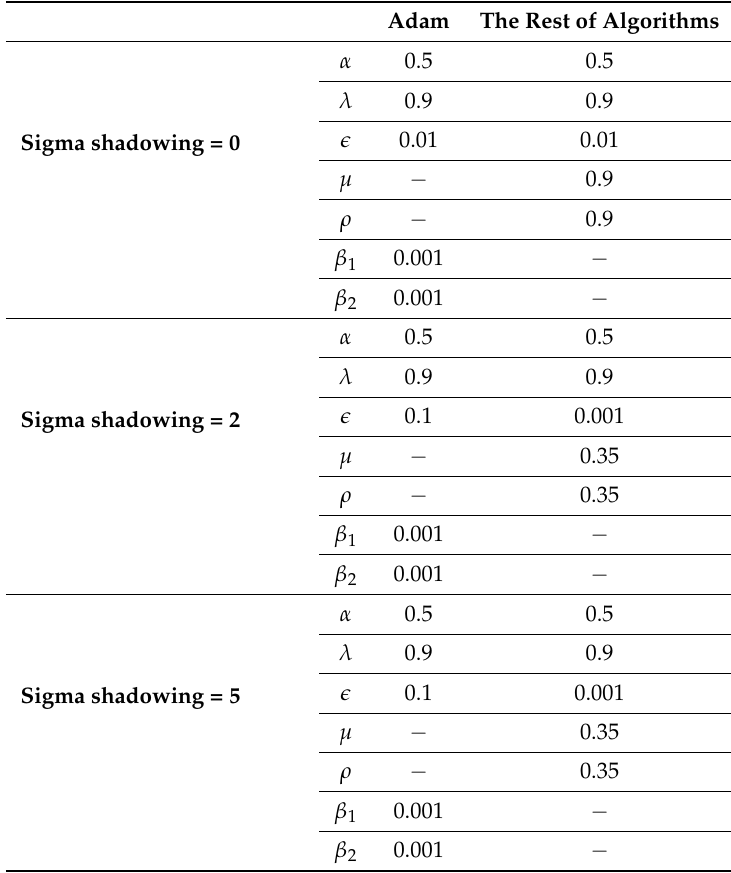
Table 2. Values of different used